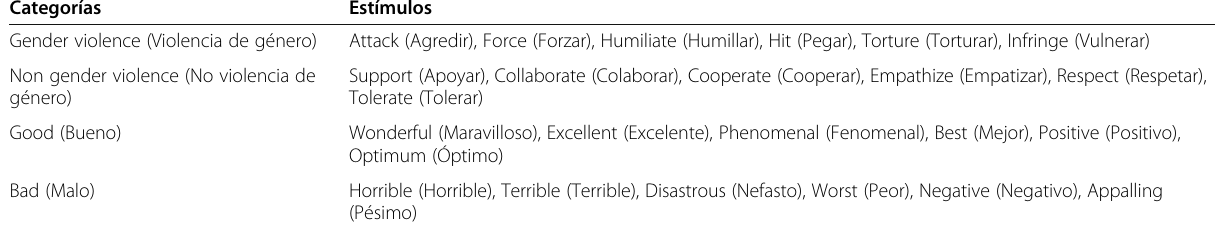
Table 4 Target stimuli linked to target category and attribute category (English and original Spanish version) Categorías Estímulos Gender violence (Violencia de género) Attack (Agredir), Force (Forzar), Humiliate (Humillar), Hit (Pegar), Torture (Torturar), Infringe (Vulnerar) Non gender violence (No violencia de